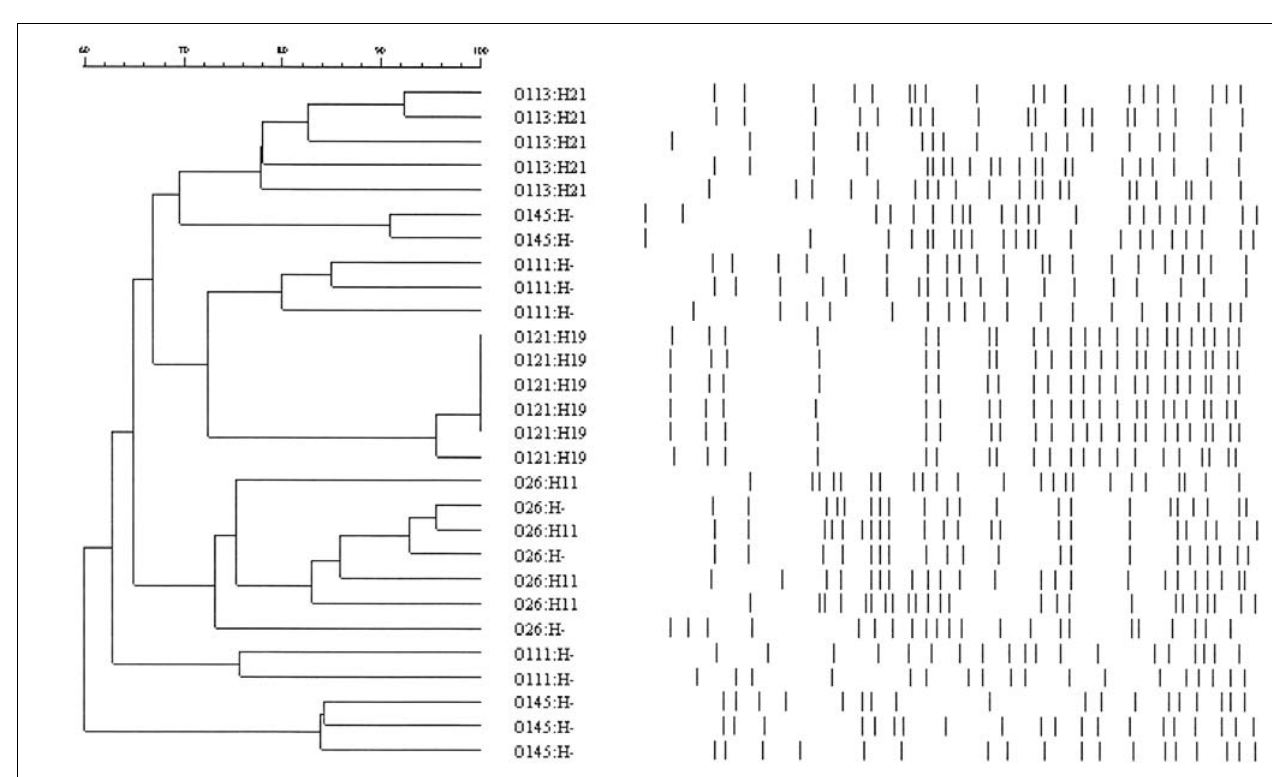
Figure 3) Dendrogram distribution of non-O157 verotoxin Escherichia coli in Canada. Pulsed-field gel electrophoresis patterns were analyzed using Molecular Analyst 2.0 (Applied Maths Kortrijk, Belgium). The dendrogram was created using the Dice coefficient by the unweighted pair group method with arithmatic mean method, with a maximum band position tolerance of 1.5%